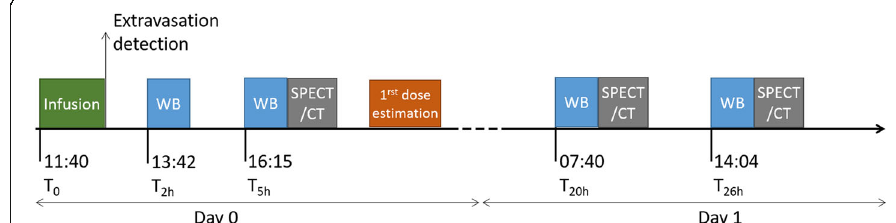
Fig. 3 Chronology of image acquisitions from the beginning of